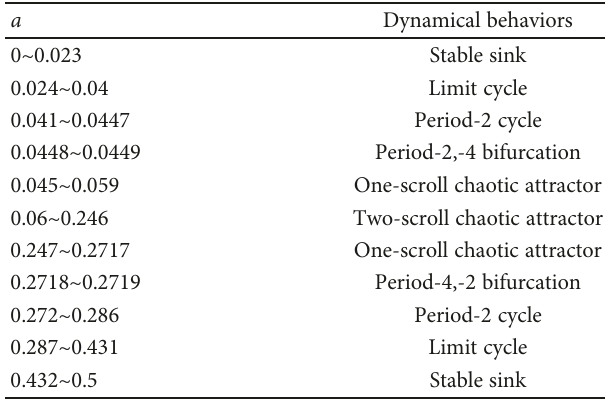
Table 2: Dynamical behaviors of the system with di ff erent a